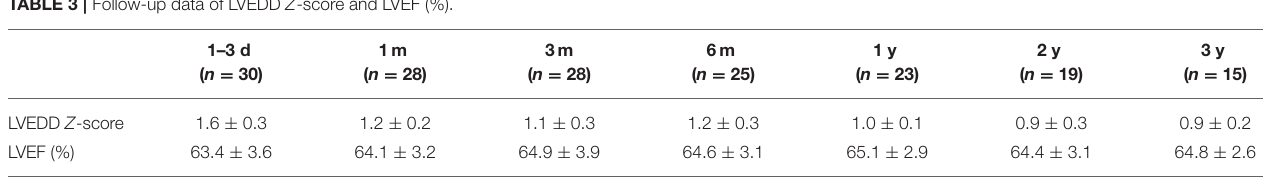
TABLE 3 | Follow-up data of LVEDD Z -score and LVEF